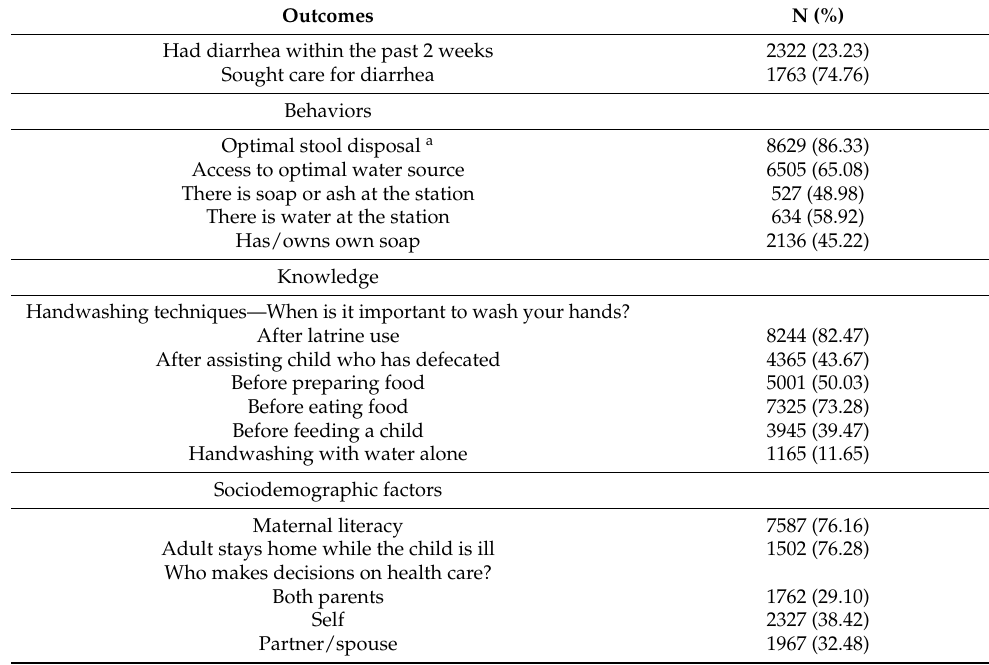
Table 2. Key indicator frequencies (N = 9996).